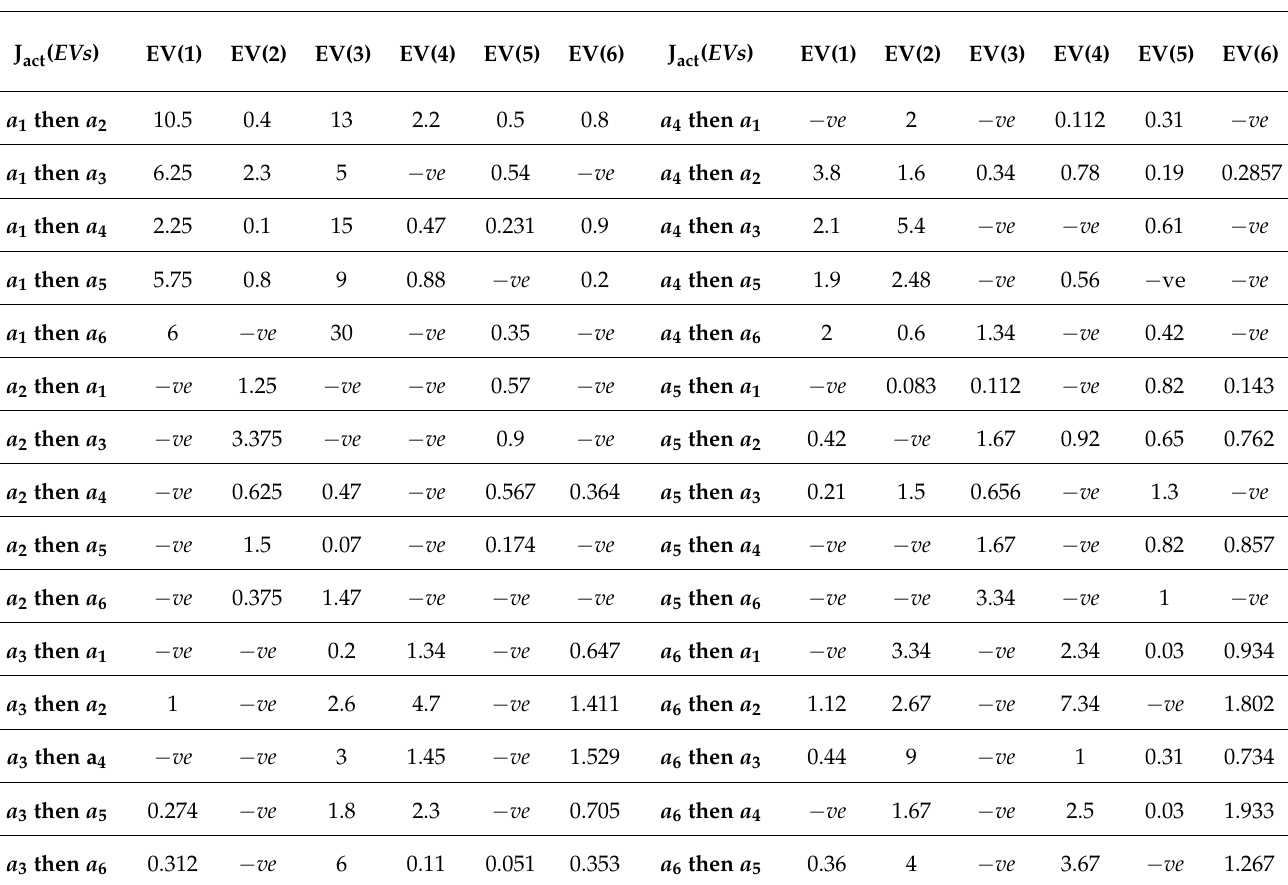
Table 5. {FG i } set; the fuzzy index for the groups of jobs {FG i } set of actions. The Fuzzy Index for the Groups of Jobs {Ui}